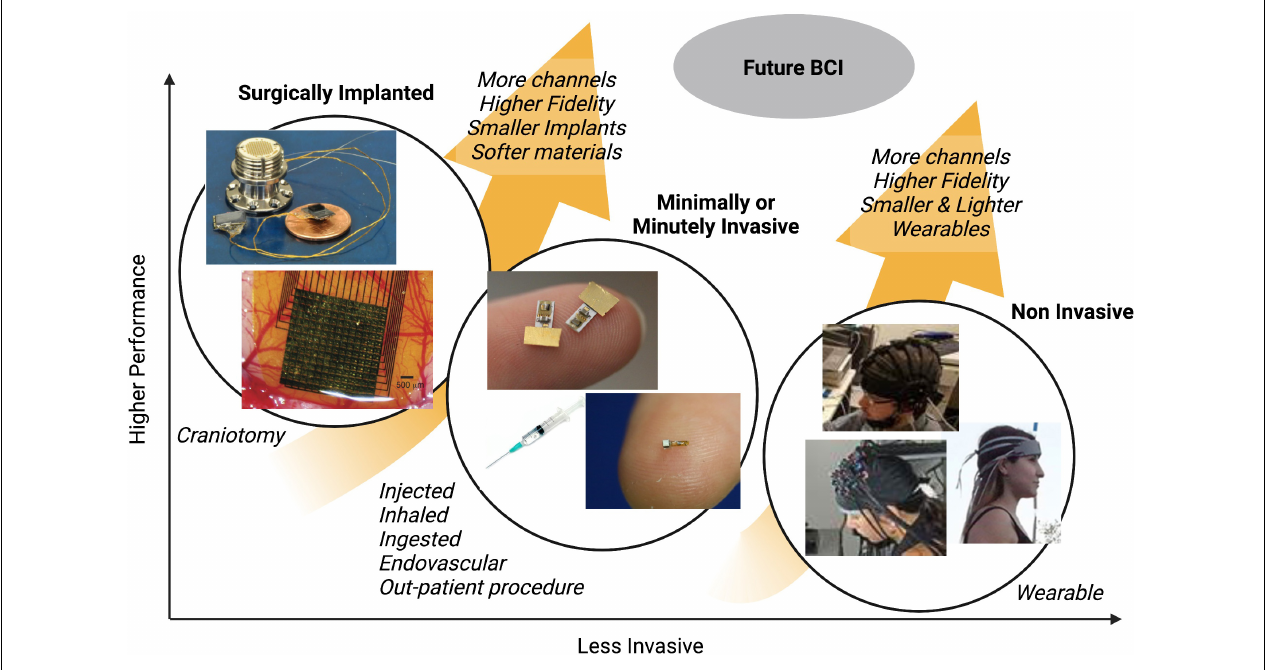
FIGURE 1 | Illustration of how different types of neurotechnology generally vary with respect to performance and